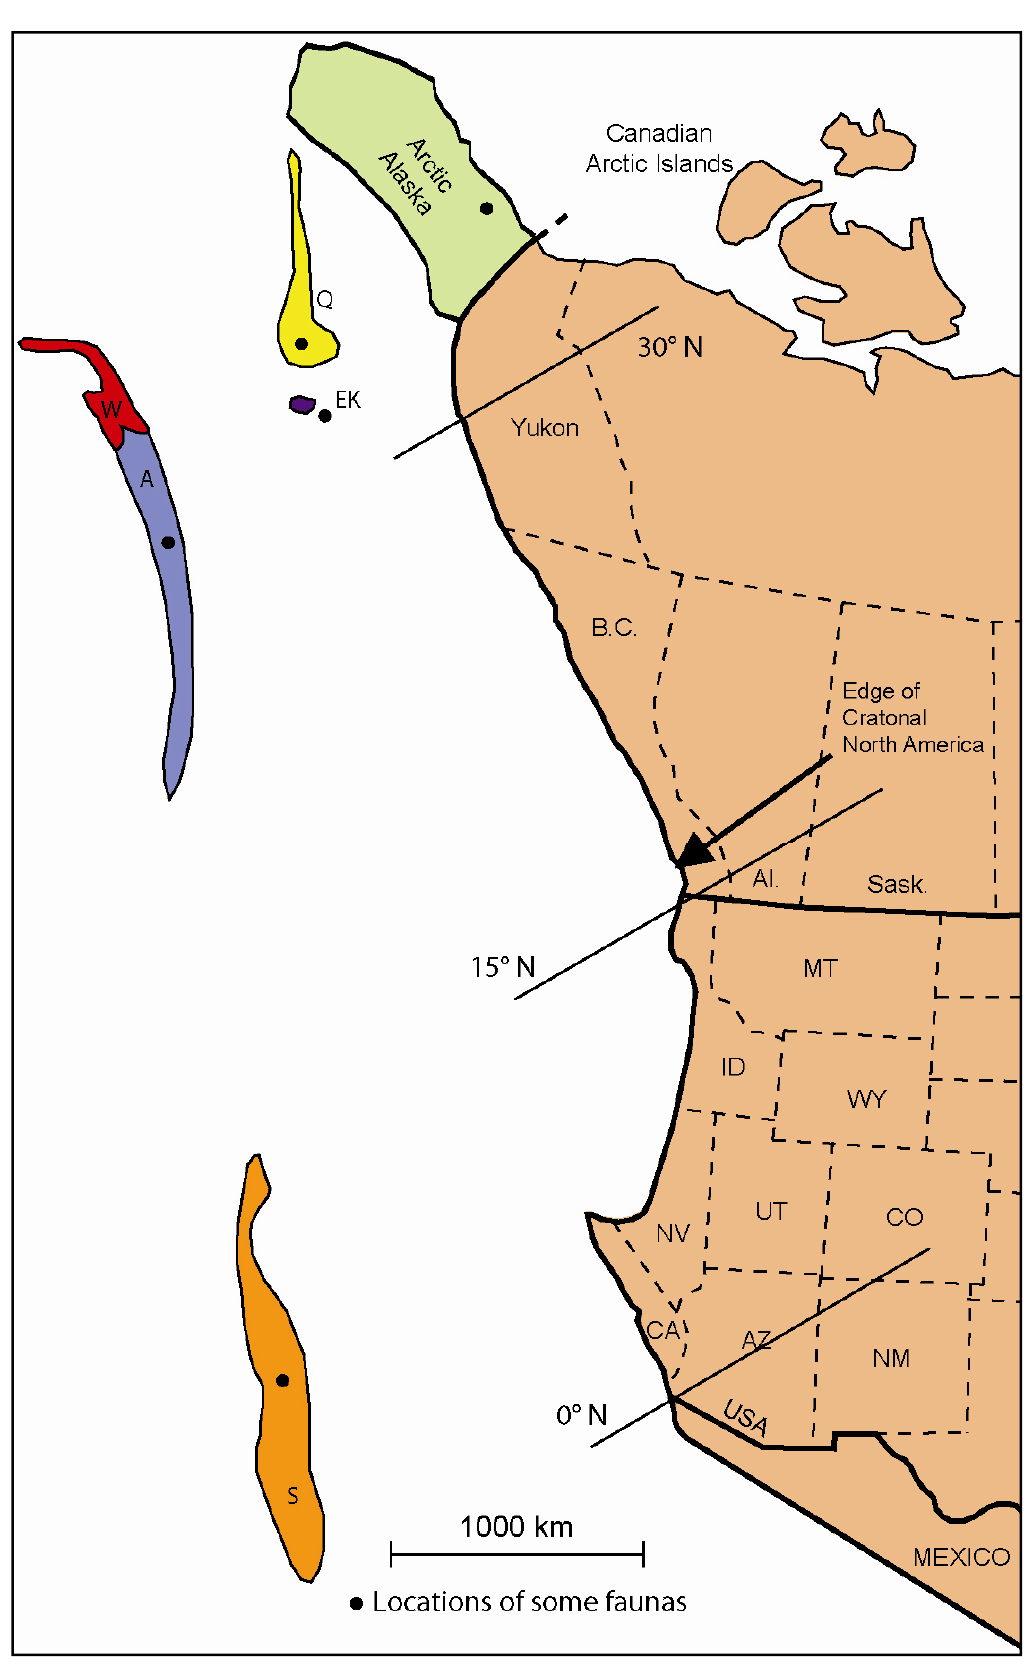
Figure 3. Interpreted Pennsylvanian position of allochthonous terranes. A = Alexander; EK = Eastern Klamath; Q = Quesnellia; S = Stikine; W = Wrangellia terranes. Paleolatitudes for cratonal North America are from Scotese and McKerrow